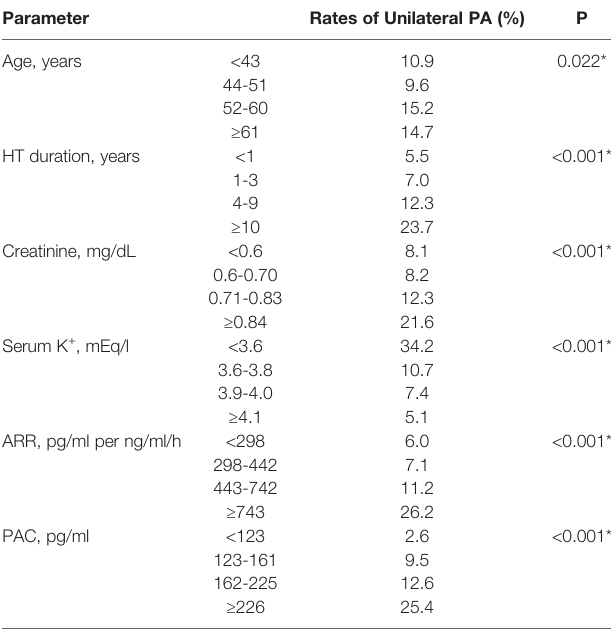
TABLE 4 | Odds ratios and 95% con fi dence intervals for each parameter to distinguish unilateral PA patients without apparent adrenal tumors from